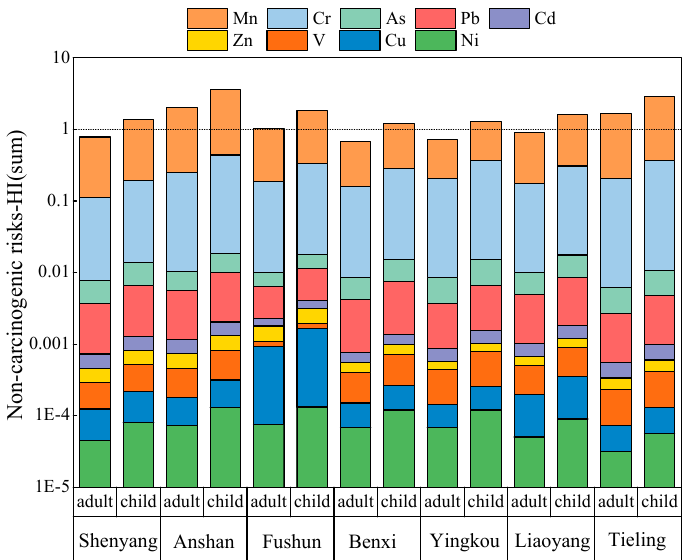
Figure 6. The non ‐ carcinogenic risks (sum HI) of total nine metal elements to adults and children at seven cities. The y ‐ coordinate is the logarithmic coordinate.